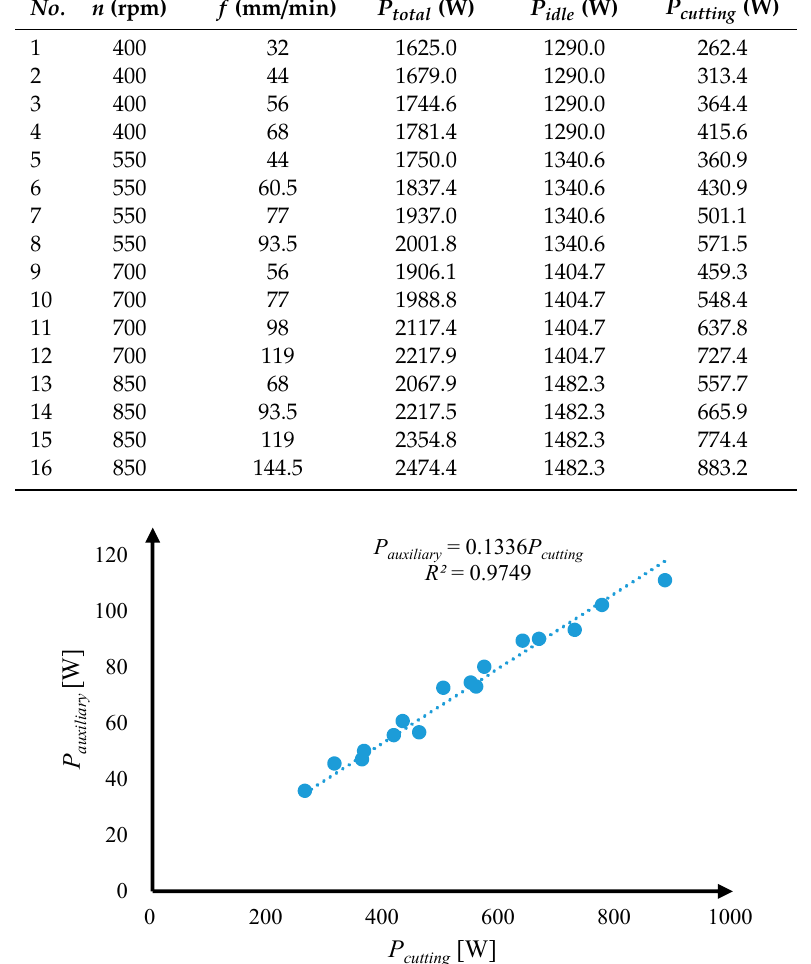
Table 2. The measured total power ( P total ) and the calculated cutting power ( P cutting ) in Experiment-I.